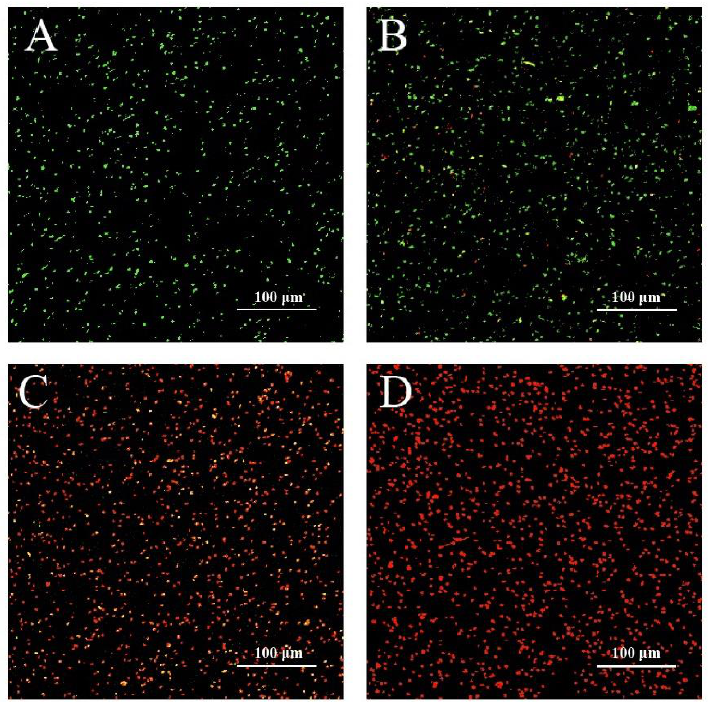
Figure 3. Integrity of the cell membrane of C. sakazakii treated with LC-EO observed by CLSM: ( A ) 0 (Control); ( B ) 1/4MIC; ( C ) 1/2MIC; ( D ) MIC.